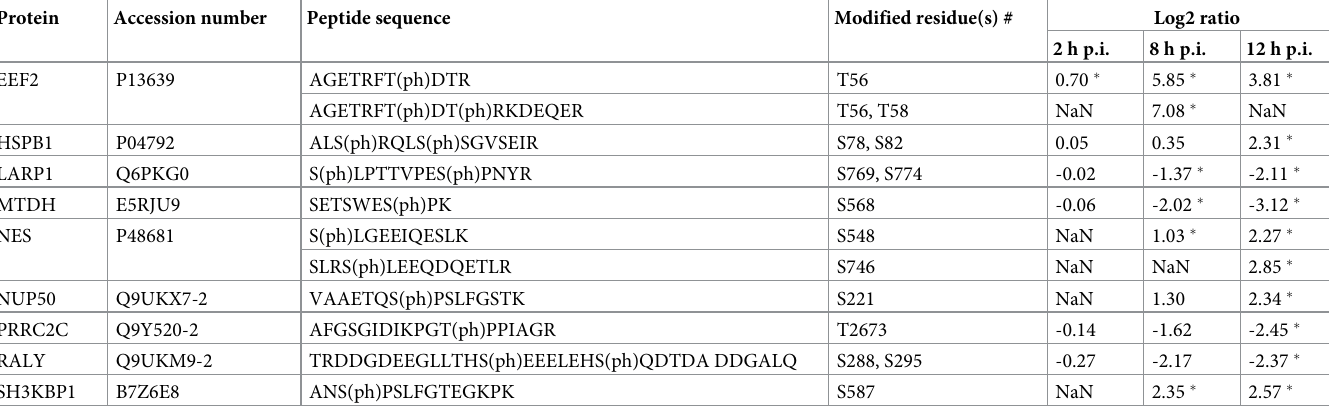
(ph) indicates the preceding amino acid residue was modified by phosphorylation. # amino acid residue number according to PhosphoSitePlus [23]. � Significantly changed phosphorylation status at this time point with Benjamini-Hochberg FDR 0.05. NaN: peptide was not identified at this time